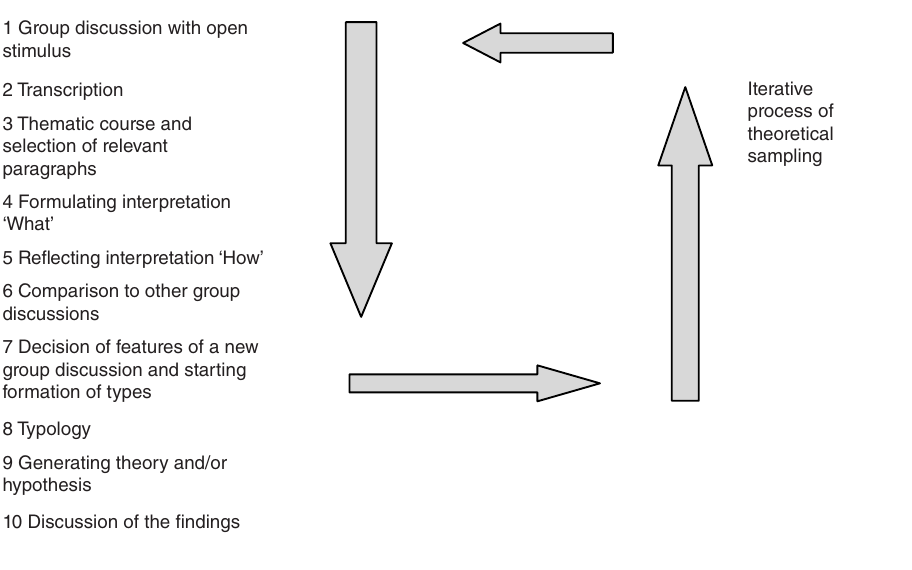
Table 2: Procedures of knowledge generation in the documentary